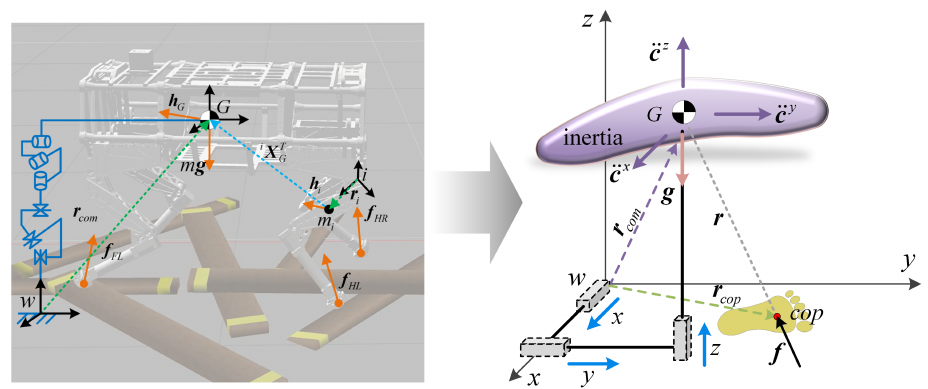
Figure 2. Floating-based quadruped robot and its simplified template model, which has significant model error due to simplification for use in motion